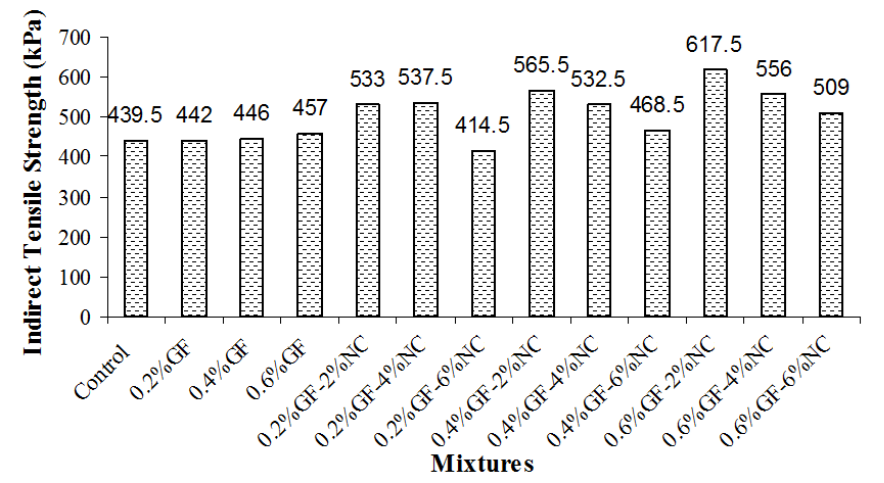
Fig. 8. Indirect tensile strength of the